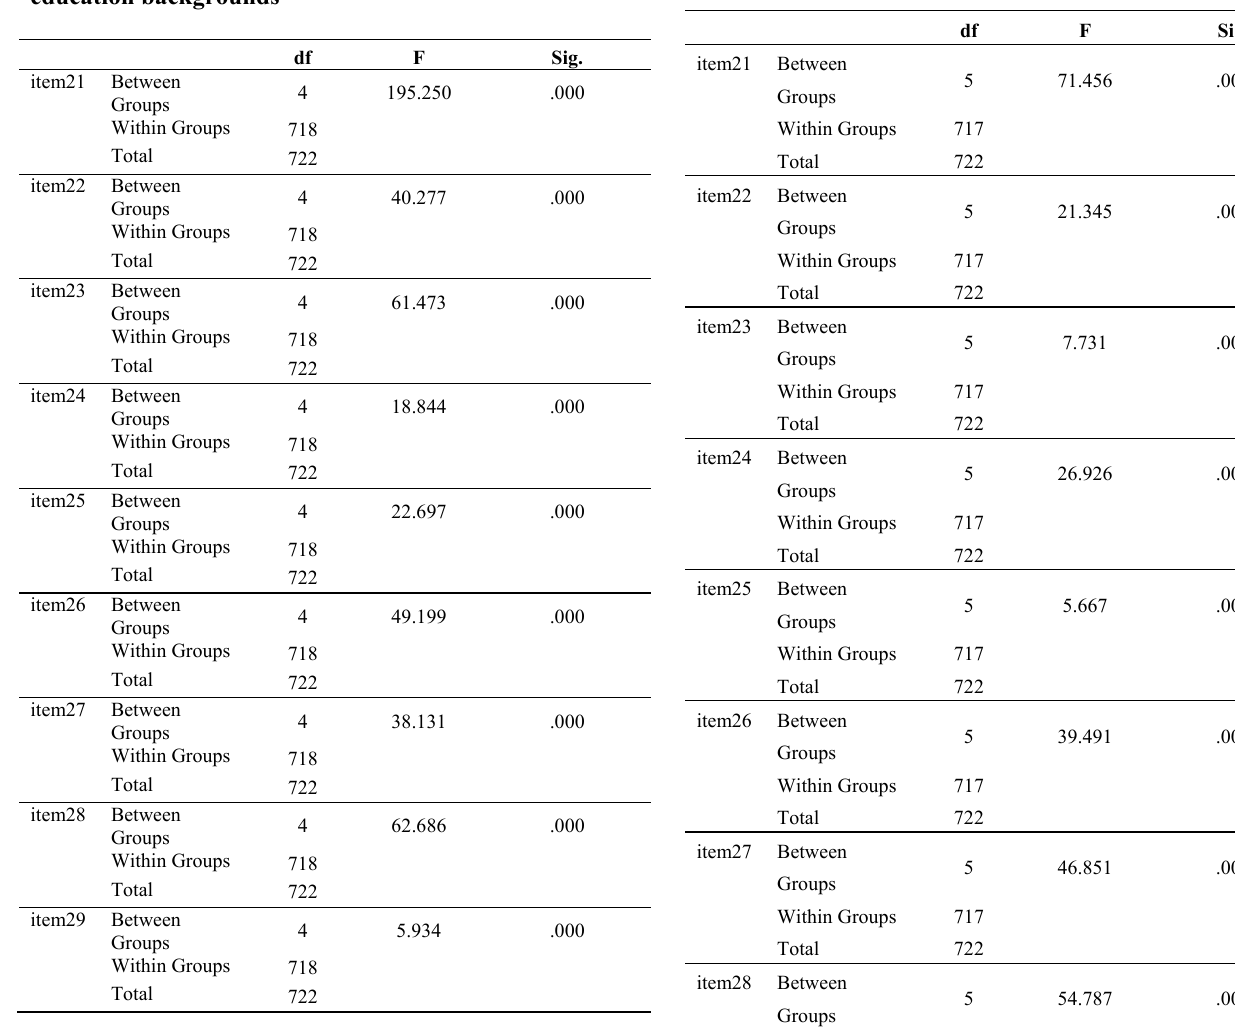
Table 16: The ANOVA for the influence of the features of furniture product design on the fuzzy semantics of